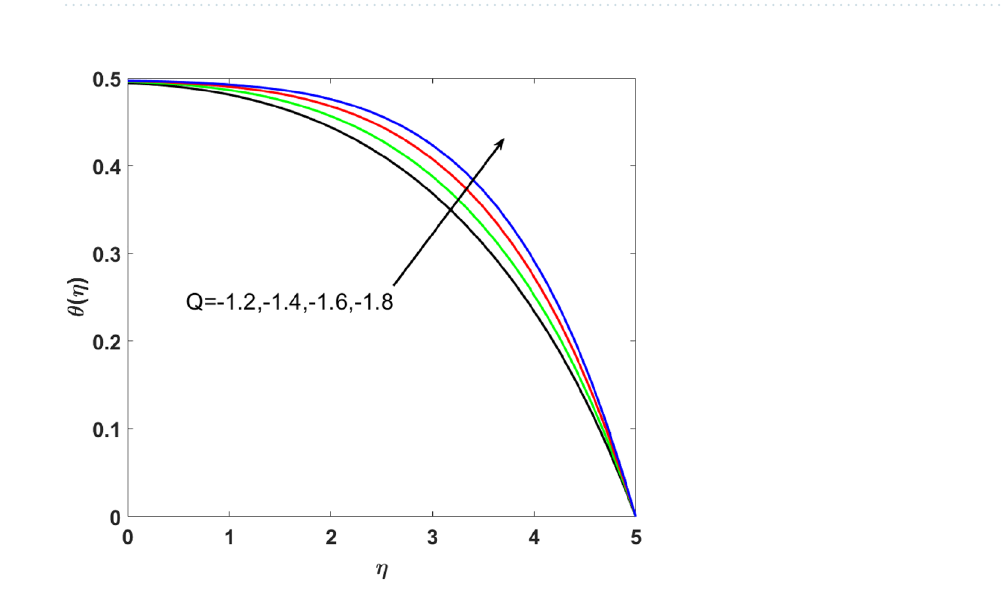
Figure 7. θ(η) versus Q < 0